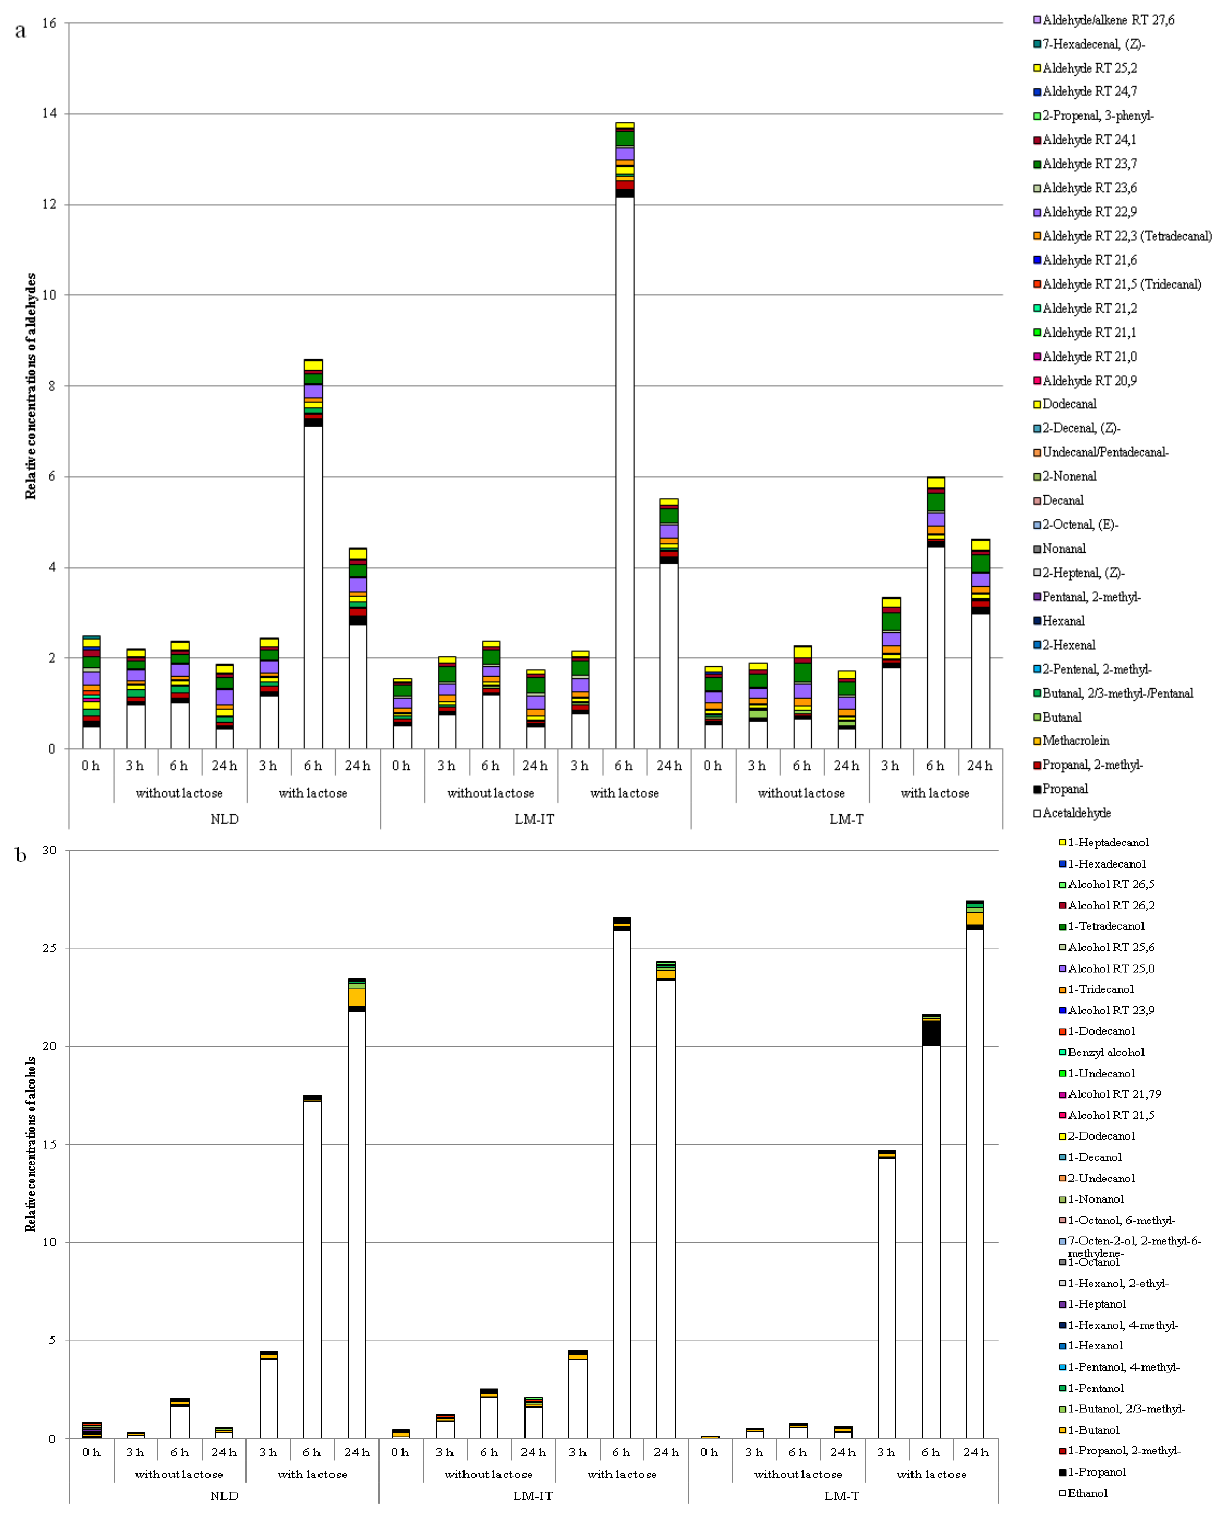
Figure 6. Relative concentrations of aldehydes ( a ) and alcohols ( b ) present in the NLD-, LM-IT- and LM-T-samples at baseline (0 h) or after incubation with or without lactose for 3 h, 6 h or 24 h. NLD: normal lactose digestion; LM-IT: lactose malabsorption with abdominal complaints; LM-T: lactose malabsorption with without abdominal complaints.